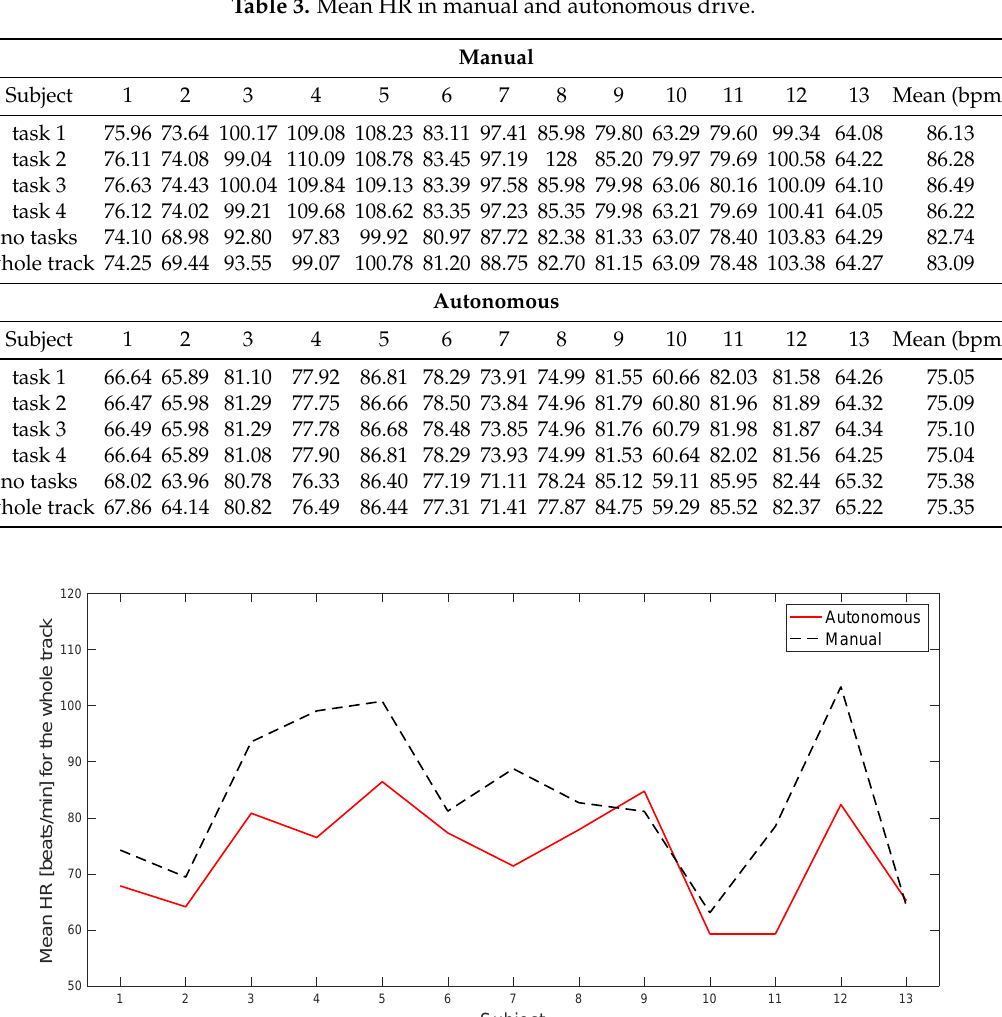
Table 3. Mean HR in manual and autonomous drive.